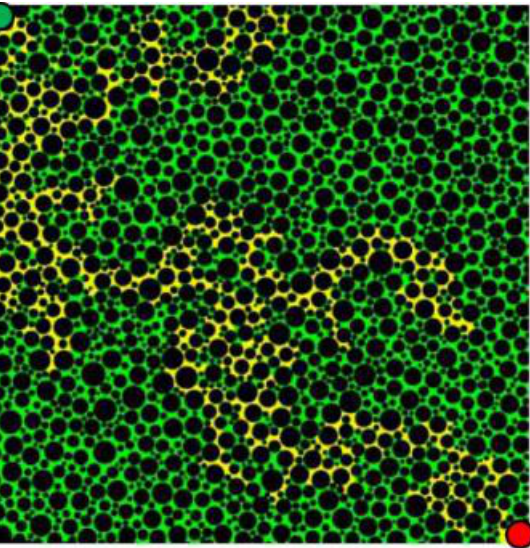
Figure 6. The volume fraction of residual oil (green) from the experiment after breakthrough.